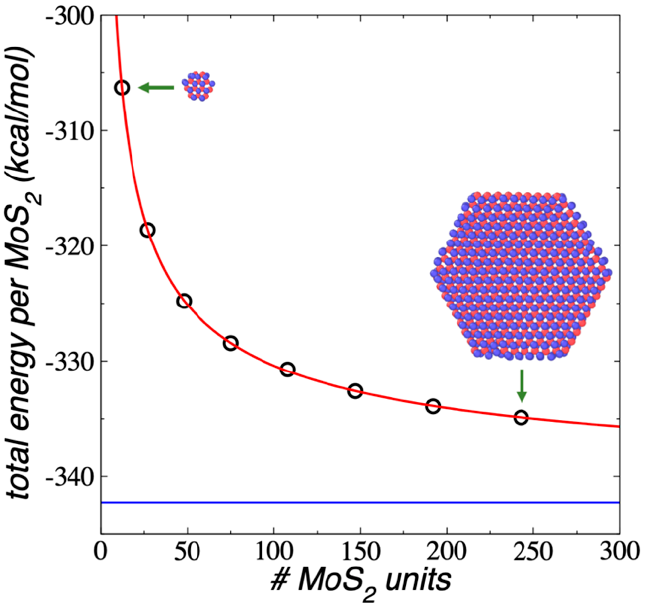
Figure 2. E #MoS2 of 1L flakes (black circles) as a function of the number of MoS 2 units, under vacuum and NVT conditions at 298.15 K. The red line represents a fitting to an exponential decay expression and the blue line represents the plateau value. The inset snapshots correspond to the equilibrated conformations of the smallest (Mo 12 S 24 ) and largest (Mo 243 S 486 ) flakes. Blue and red spheres represent Mo and S atoms, respectively.